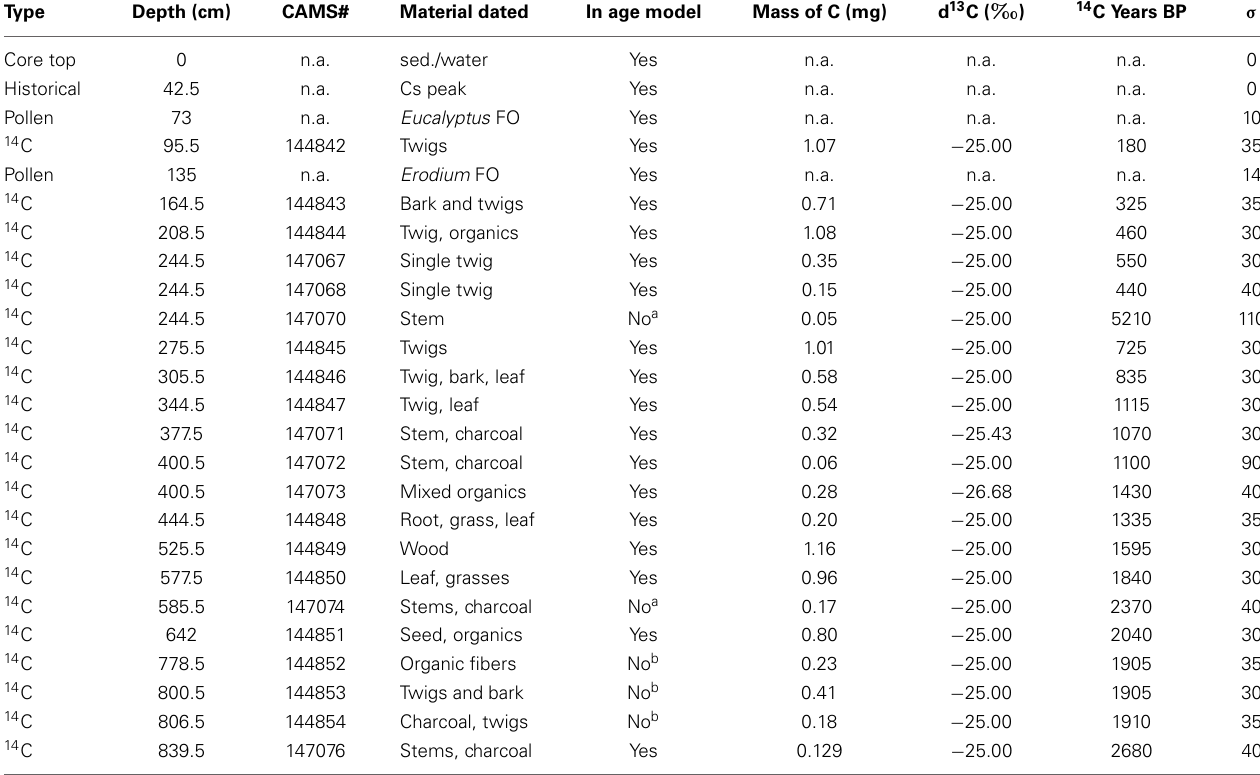
Table 1 | Dates obtained for developing the age